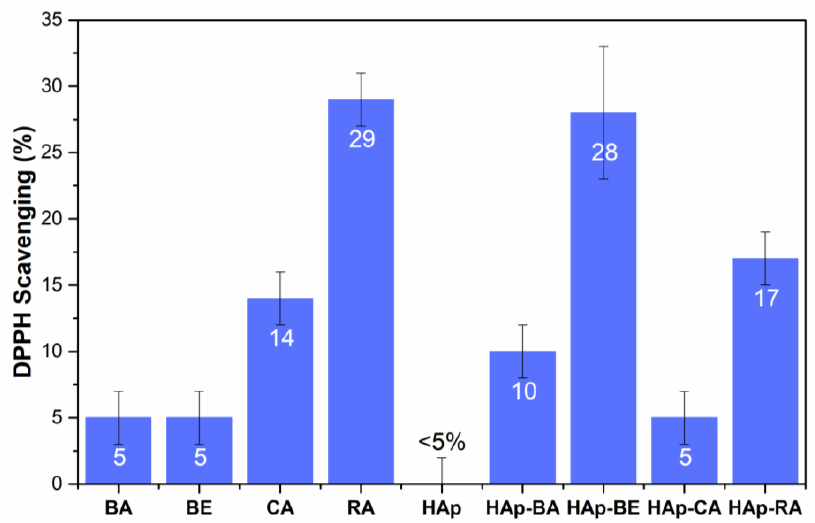
Figure 9. Antioxidant activity. DPPH scavenging ability percentage of polyphenols in solution and after adsorption on hydroxyapatite (HAp) particles, after 20 min of reaction.